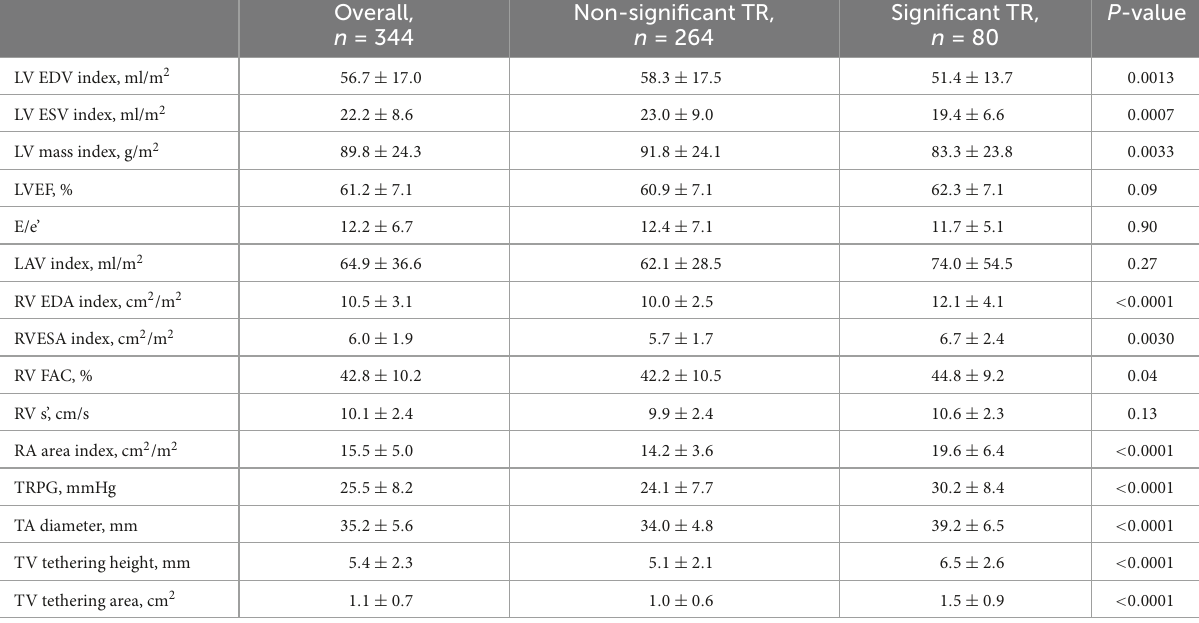
TABLE 2 Echocardiography parameters stratified by presence or absence of significant